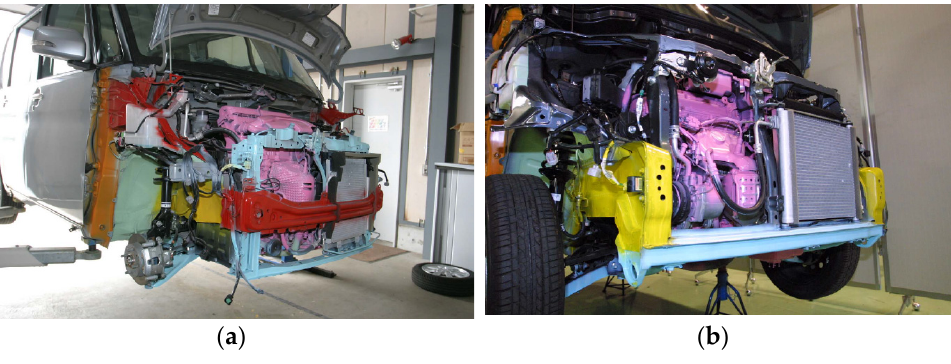
Figure 3. The structure of two minicars ( a ) and ( b ).